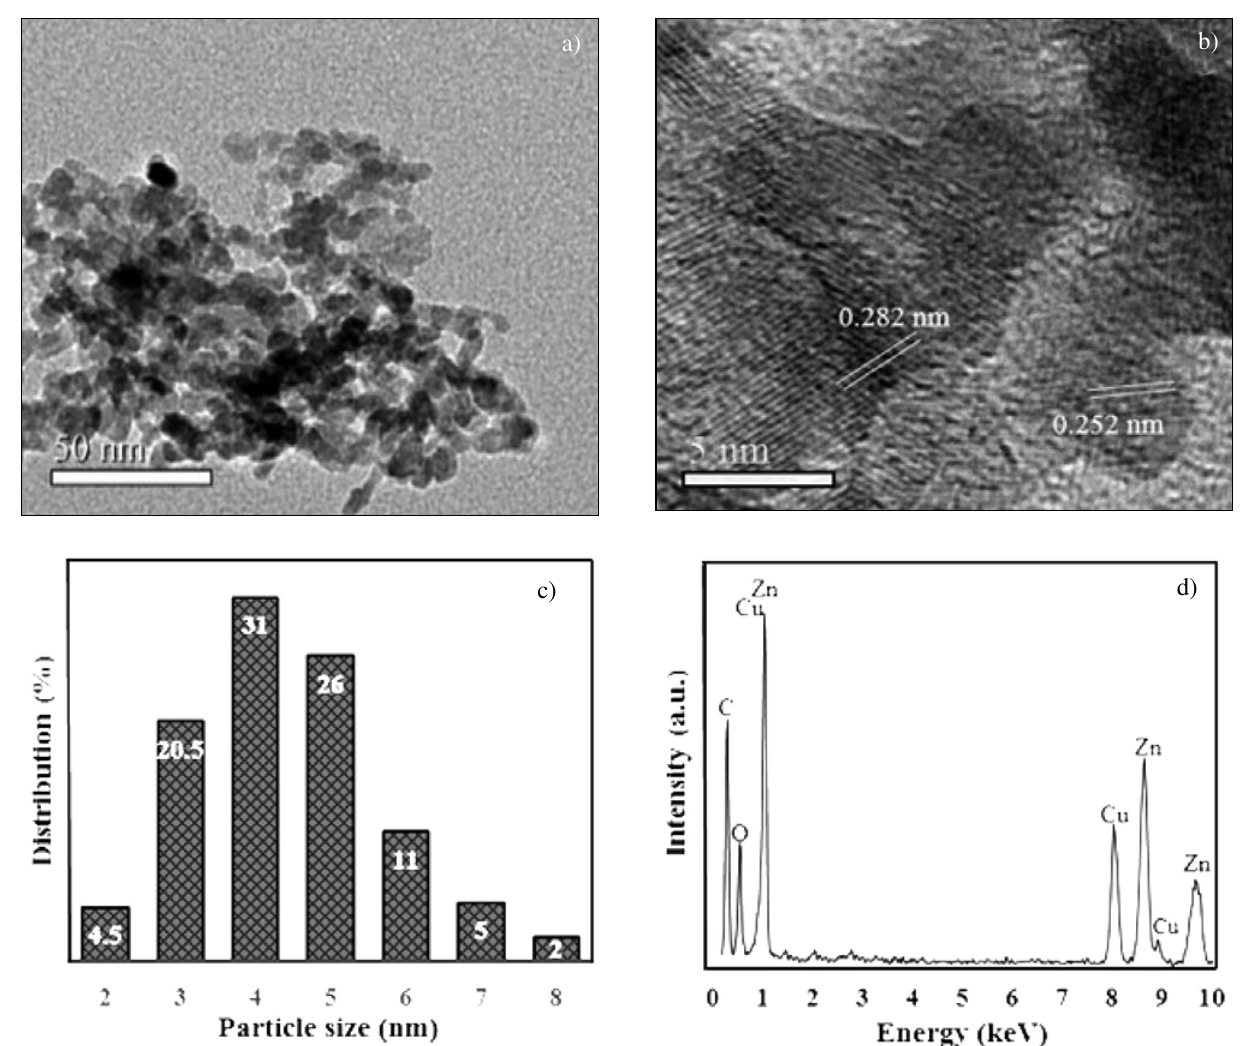
Figure 4 . (a,b) TEM image, (c) particle size distribution, and (d) EDS analysis, of 20CuO-ZnO nanocatalyst.